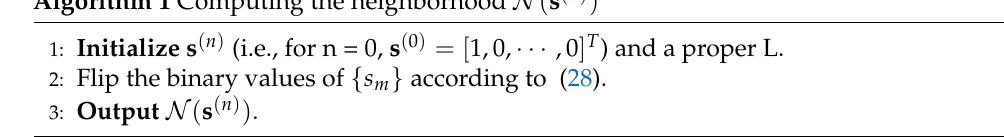
Algorithm 1 Computing the neighborhood N ( s ( n )